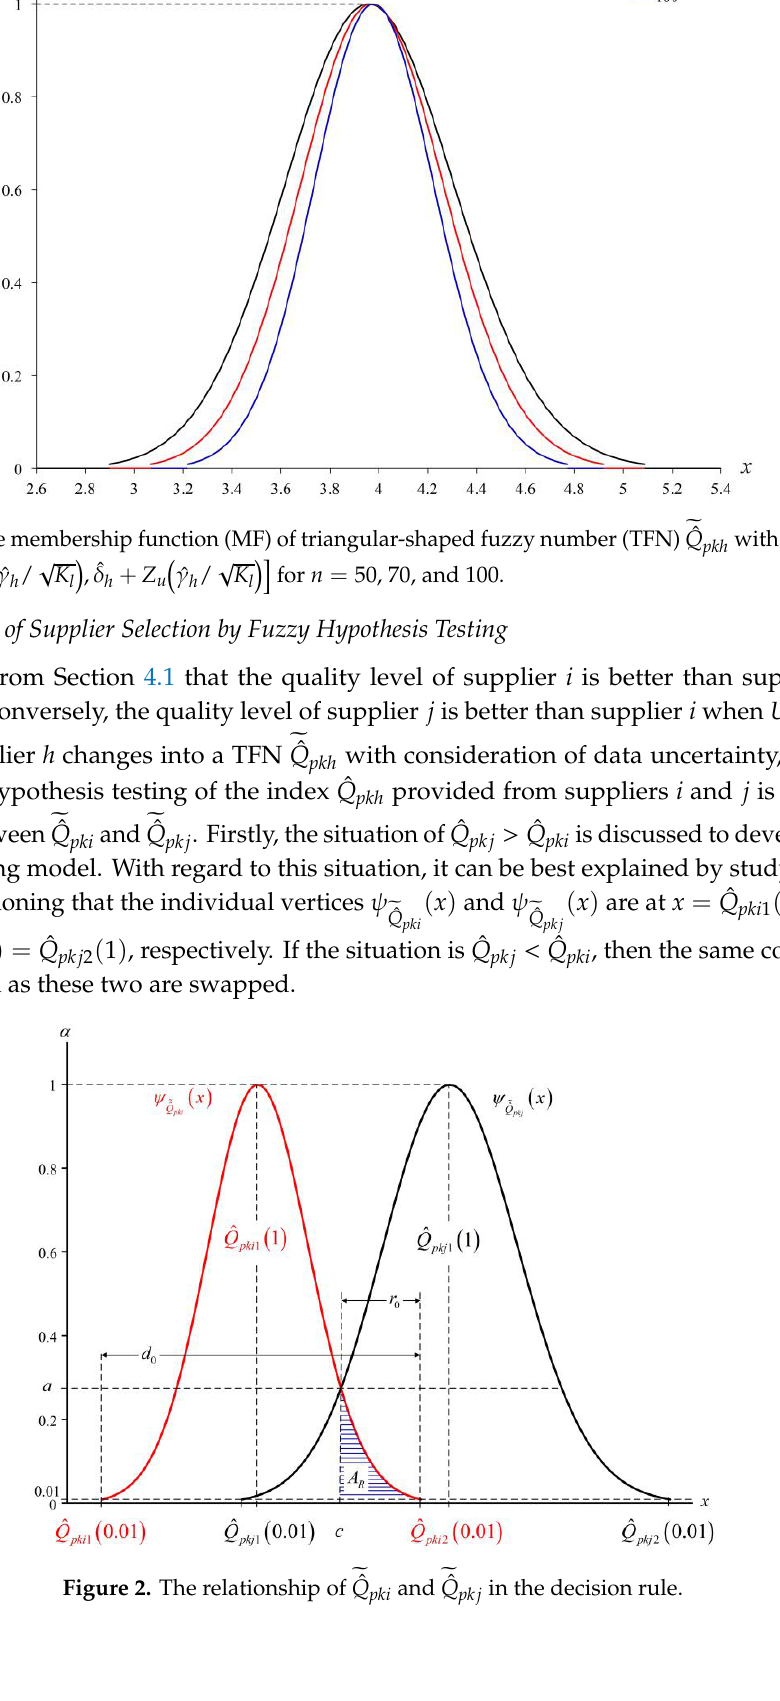
Figure 2. The relationship of ˆ